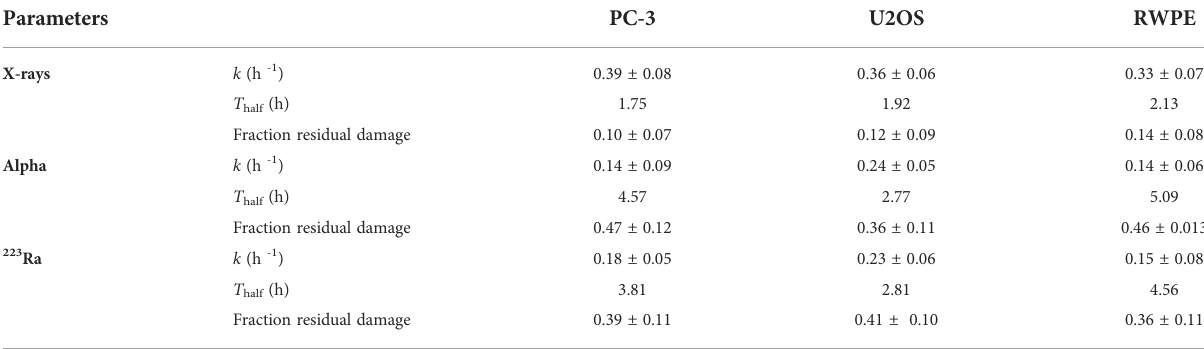
TABLE 3 Initial rate of DSB repair (k) and DSB repair half-life (T half )for different irradiation setups; the half-life is calculated from 0.69/k.